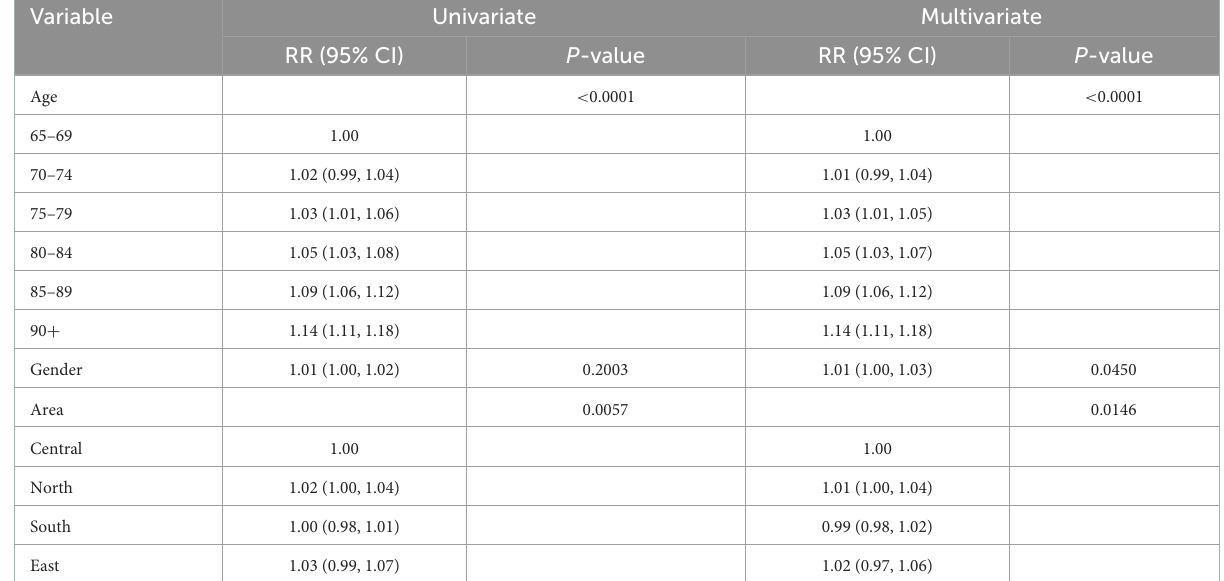
TABLE 2 Effects of age, gender, geographic on the risk of incidence rate of dementia by Poisson regression